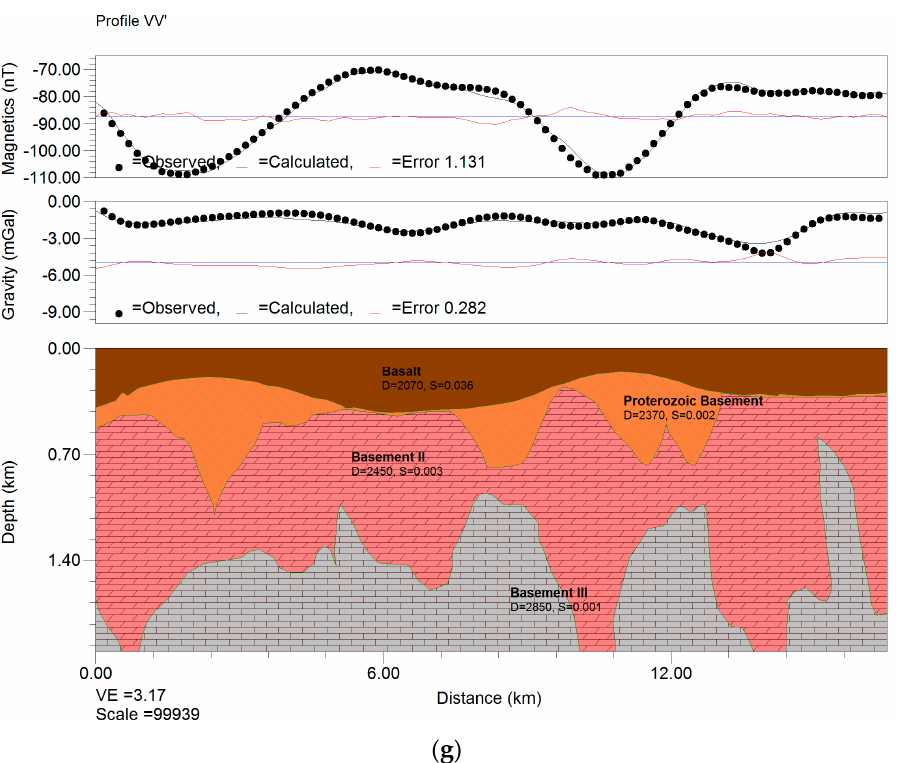
Figure 10. ( a ) A two ‐ dimensional forward modeling result from the gravity and magnetic data obtained from Profile PP’.( b ) A two ‐ dimensional forward modeling result from the gravity and magnetic data obtainedfrom Profile QQ’. ( c ) A two ‐ dimensional forward modeling result from the gravity and magnetic data taken from Profile RR’. ( d ) A two ‐ dimensional forward modeling result from the gravity and magnetic data taken from Profile SS’. ( e ) A two ‐ dimensional forward modeling result from the gravity and magnetic data taken from Profile TT’. ( f ) A two ‐ dimensional forward modeling result from the gravity and magnetic data taken from Profile UU’. ( g ) A two ‐ dimensional forward modeling result from the gravity and magnetic data taken from Profile VV’.